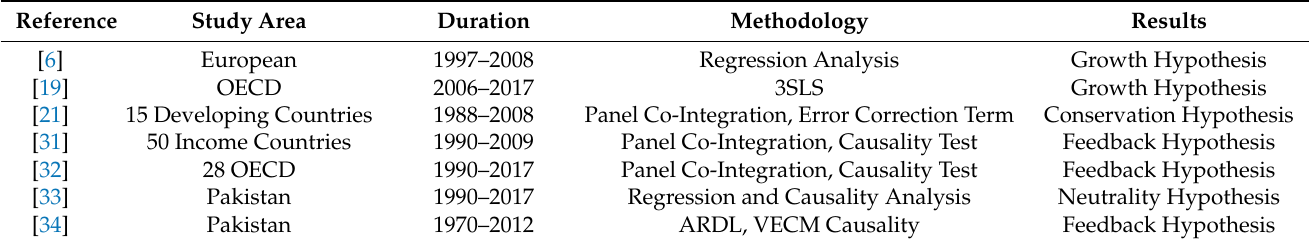
Table 1. Literature summarized on energy consumption–development